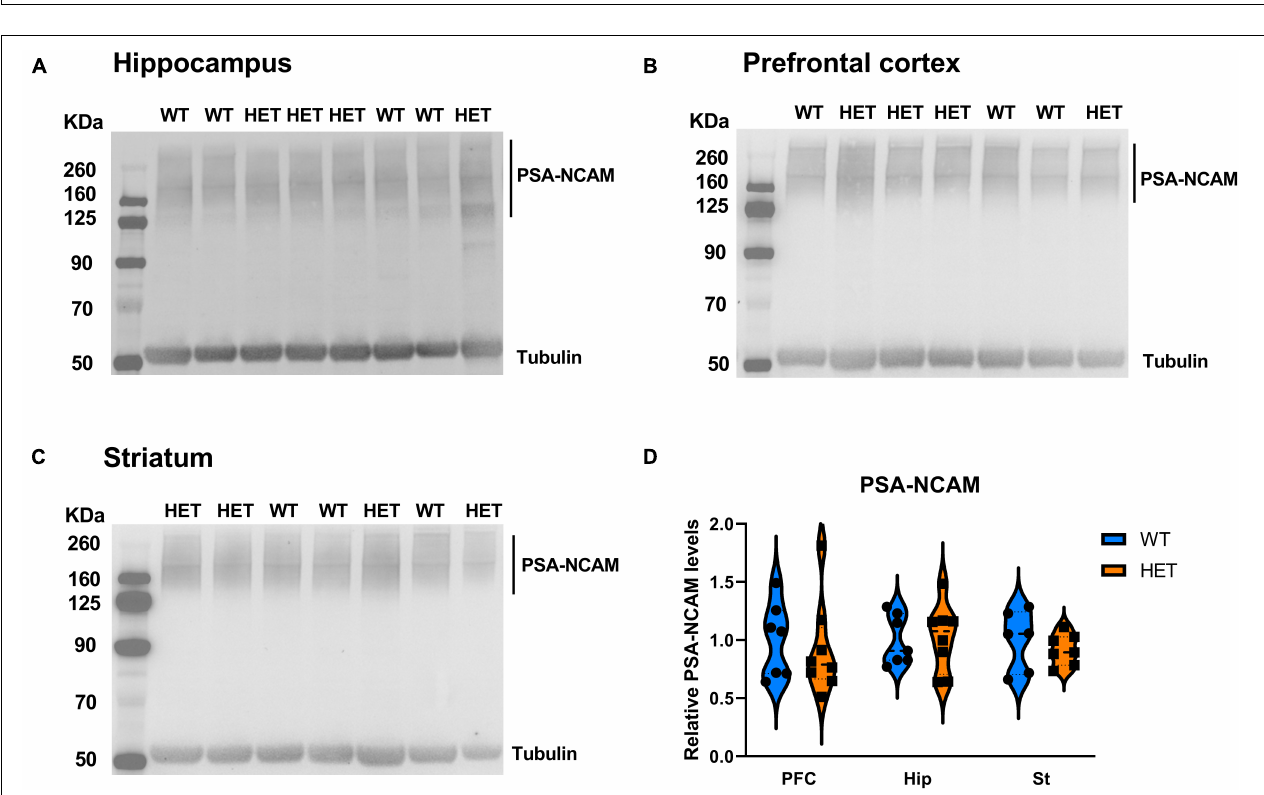
FIGURE 9 | Analysis of polysialylated proteins in different brain regions of the mouse brain. (A–C) Representative images of immunoblots of PSA in hippocampus (A) , PFC (B) , and Striatum (C) . (D) Quantification of PSA levels, normalized to α -tubulin (HET: n = 8, WT: n = 7). Data were analyzed by two-way ANOVA and presented as mean ±